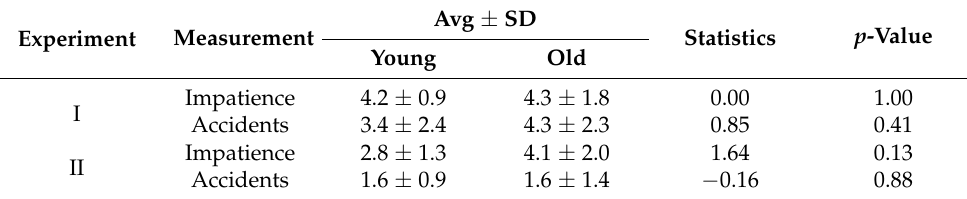
Table 3. Subjective impatience and number of accidents in young and old drivers in Experiment I and Experiment II.